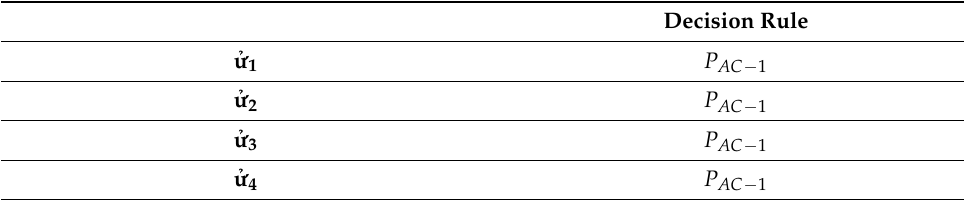
Table 7. The obtained three-ways decision rules.